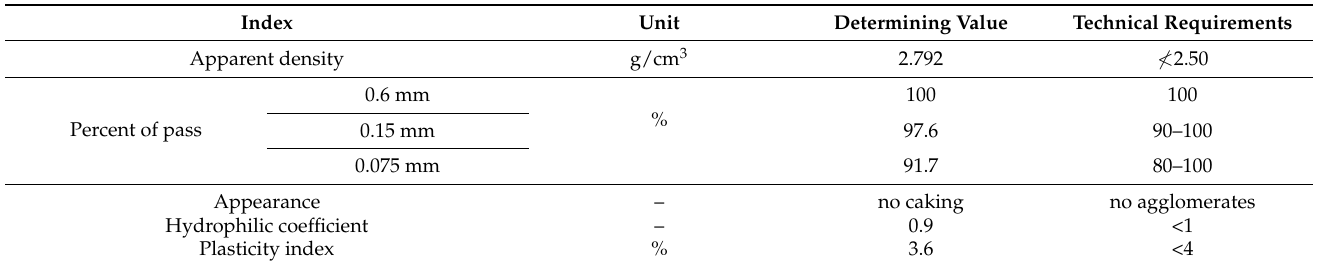
Table 4. Main technical indexes of mineral